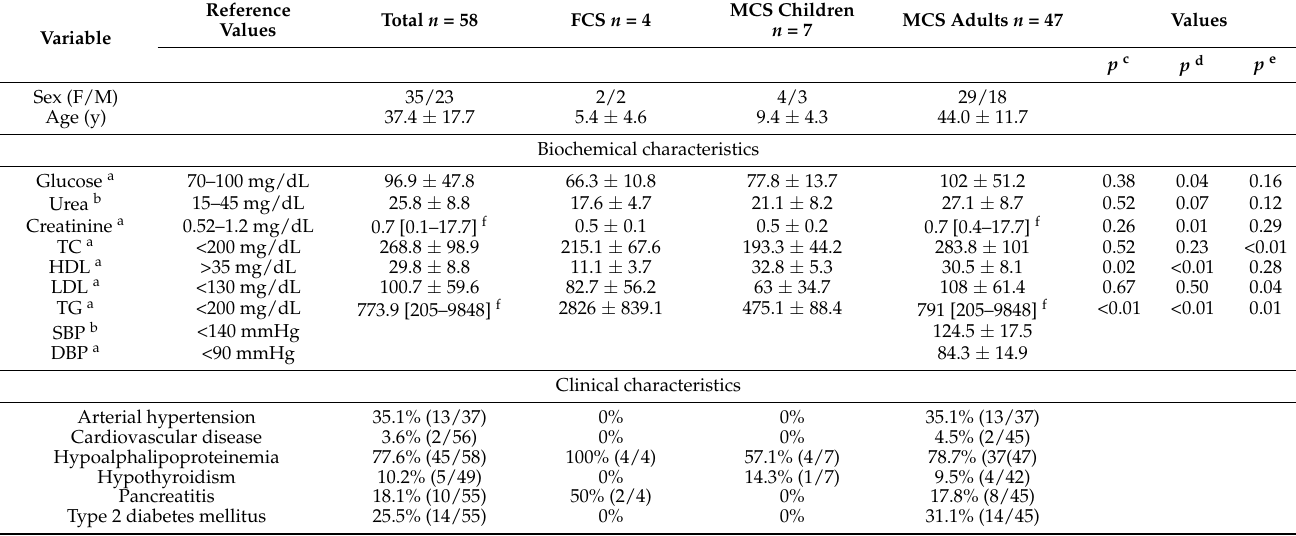
Table 1. Biochemical and clinical characteristics of patients with primary